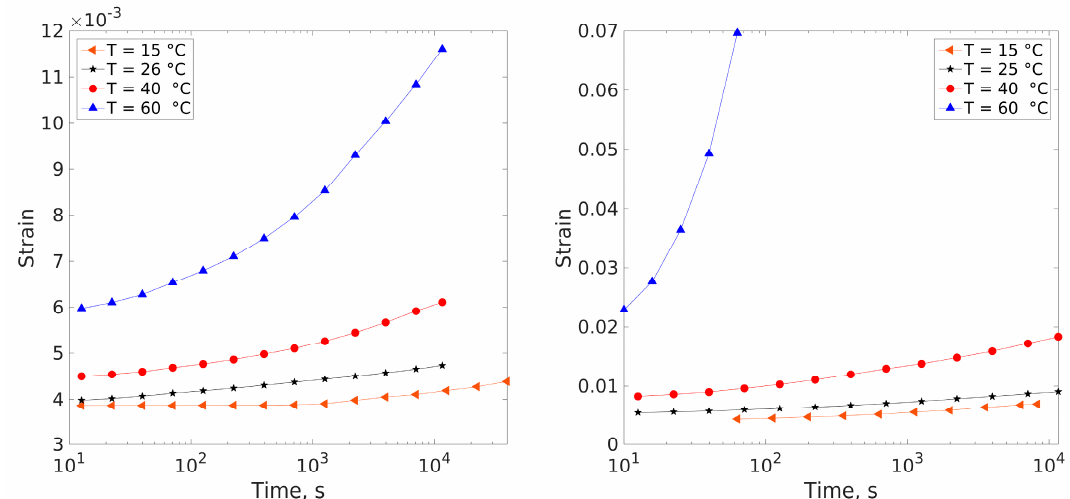
Figure 3. Variation of engineering strain with time (creep) for dry ( left ) and wet ( right ) epoxies subjected to a constant tensile stress of 10 MPa.